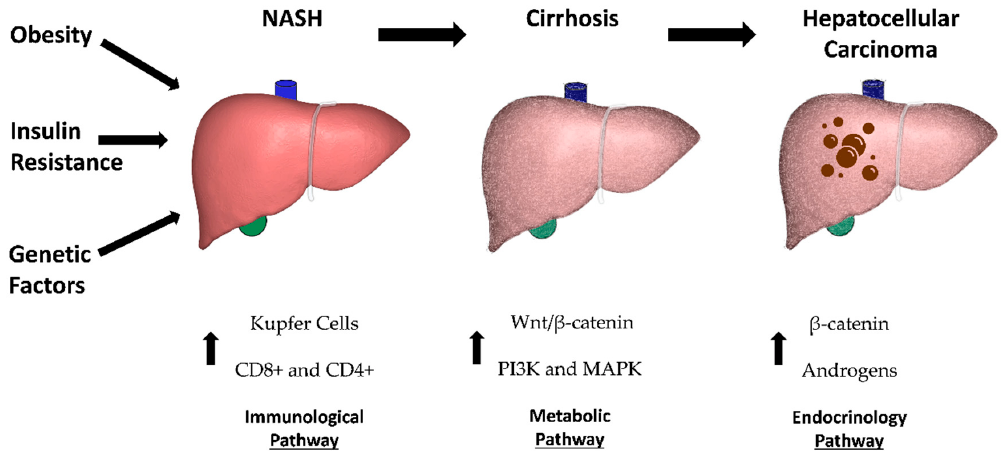
Figure 1. Risk factors and proposed mechanisms for non-alcohol steatosis (NASH) progression to hepatocellular carci- noma (HCC).